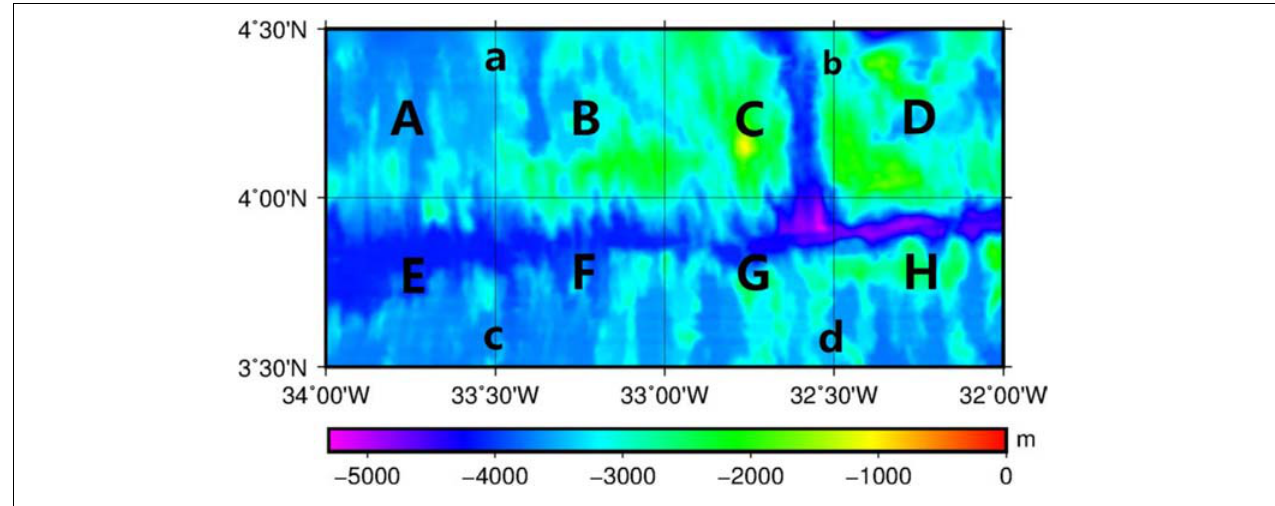
FIGURE 1 | Bathymetry of study